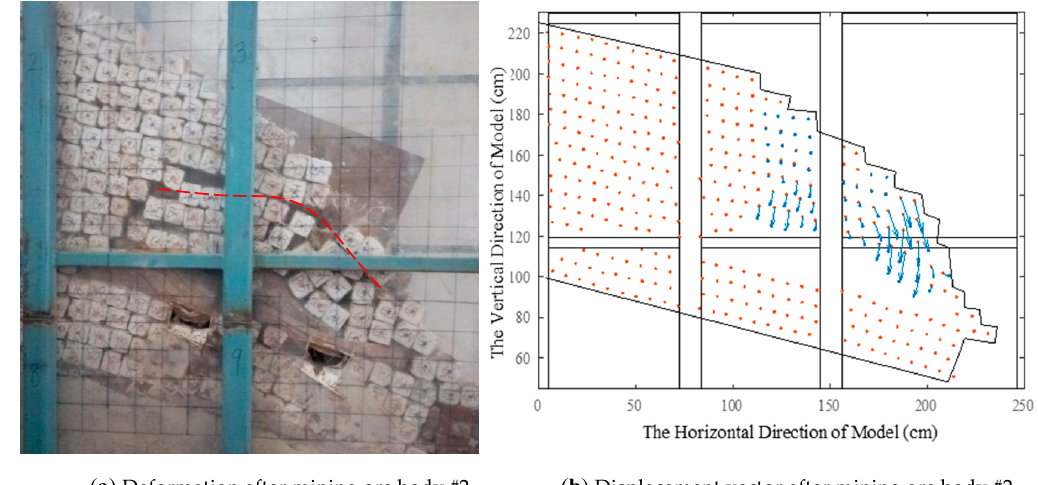
Figure 10. Slope deformation and displacement vector after mining ore body #2.